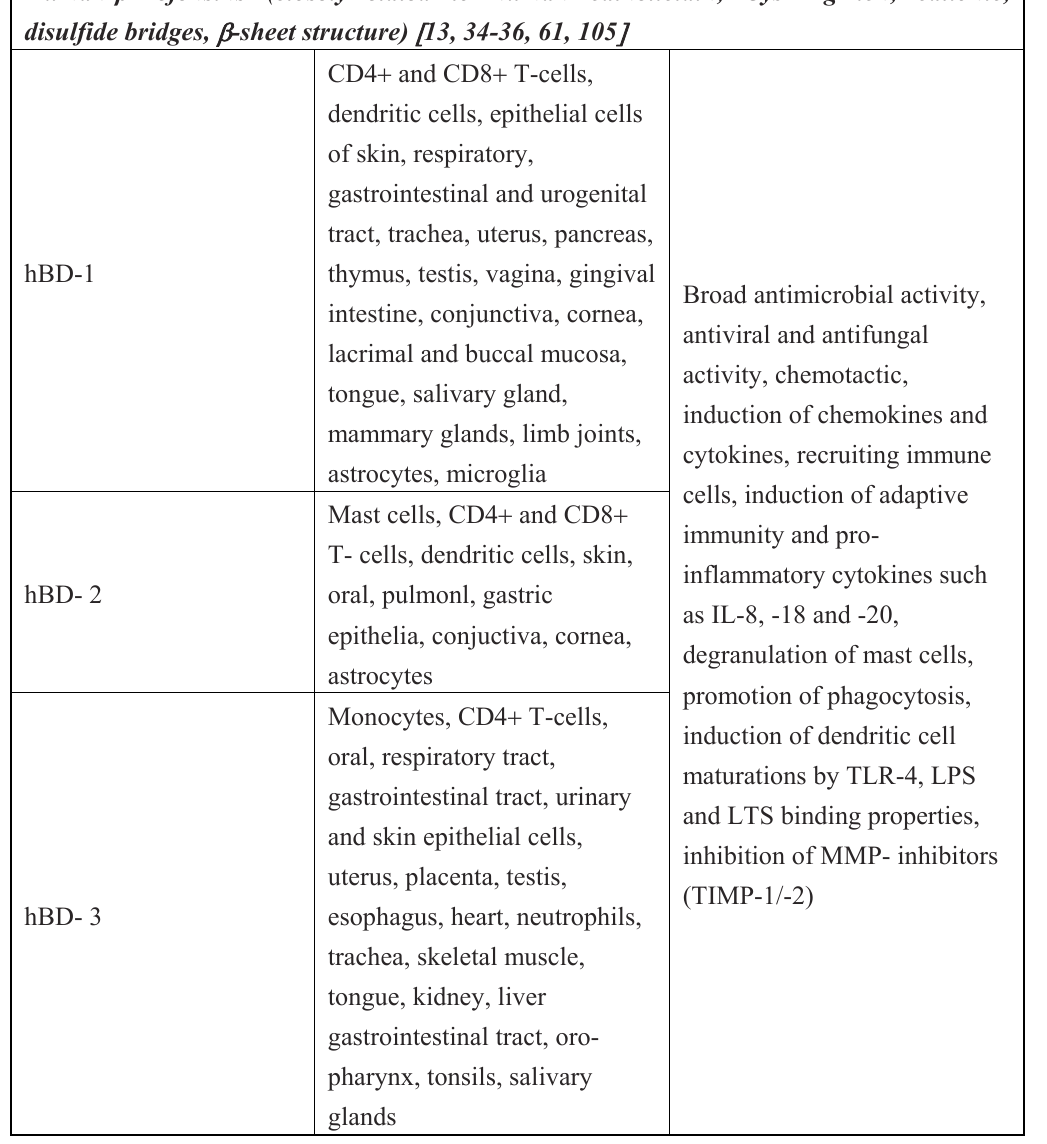
Human- β -Defensins (closely-related to human cathelicidin, Cys–Arg-rich,